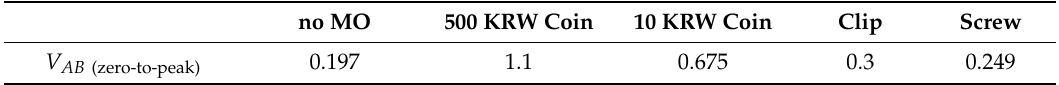
Table 2. Measured V AB for various MOs.